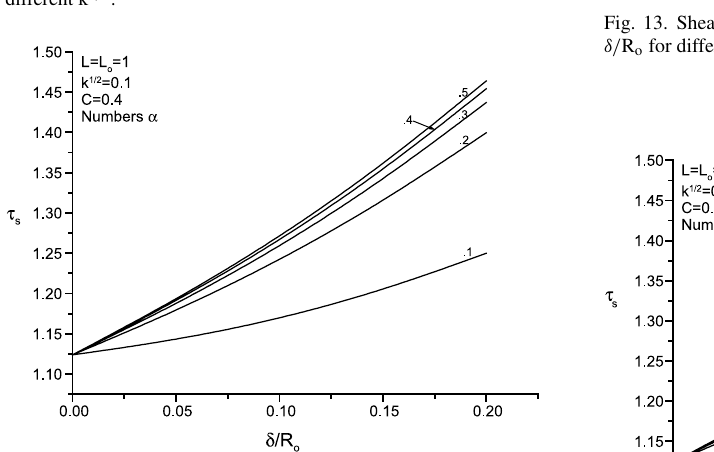
Fig. 11. Shear stress at stenosis throat, τ s versus stenosis height, δ/ R α . o for different